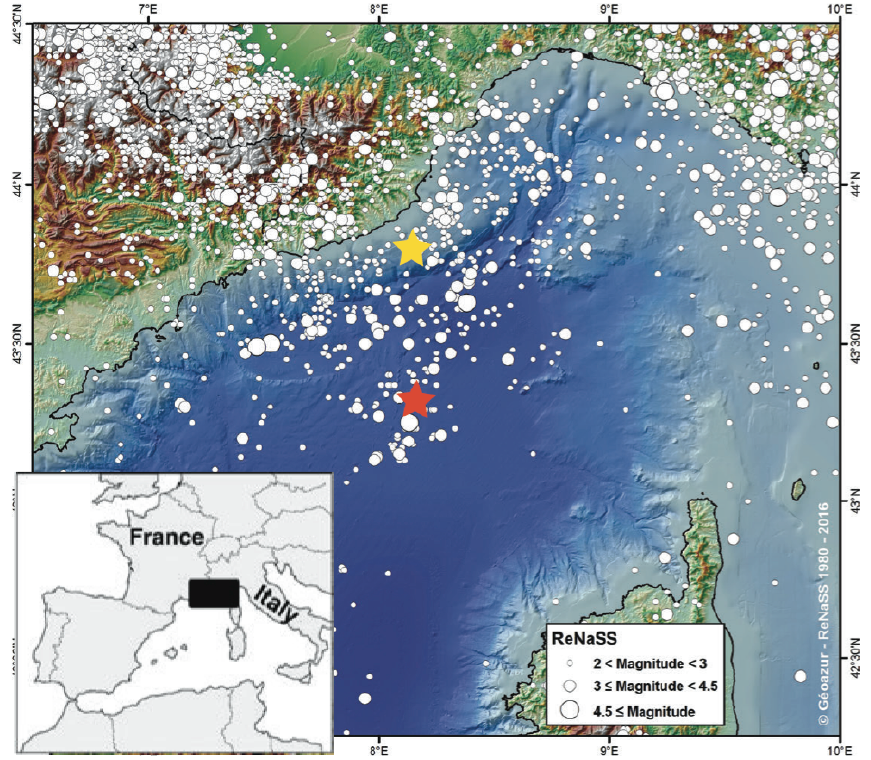
Figure 1. Seismicity map (magnitude > 2) of the Alps-Ligurian Basin junction, recorded between 1980 and 2016 (ReNaSS and SiHex catalogs). The yellow and red stars locate the approximate epicentres of the two major historical earthquakes: 23 February 1887; M W ~6.7–6.9 [3], and 19 July 1963; Ml = 6.0 [1], respectively.